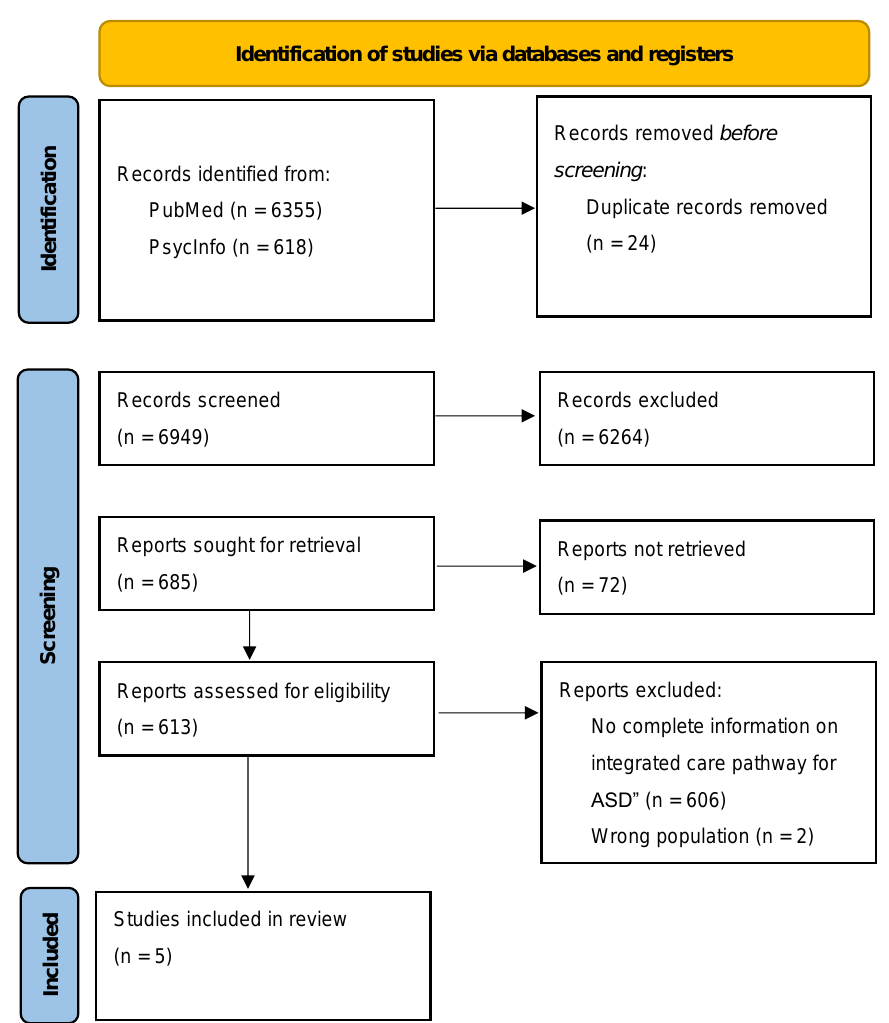
Figure 1. PRISMA 2020 Flow Diagram presenting study screening and selection process From: Page et al.